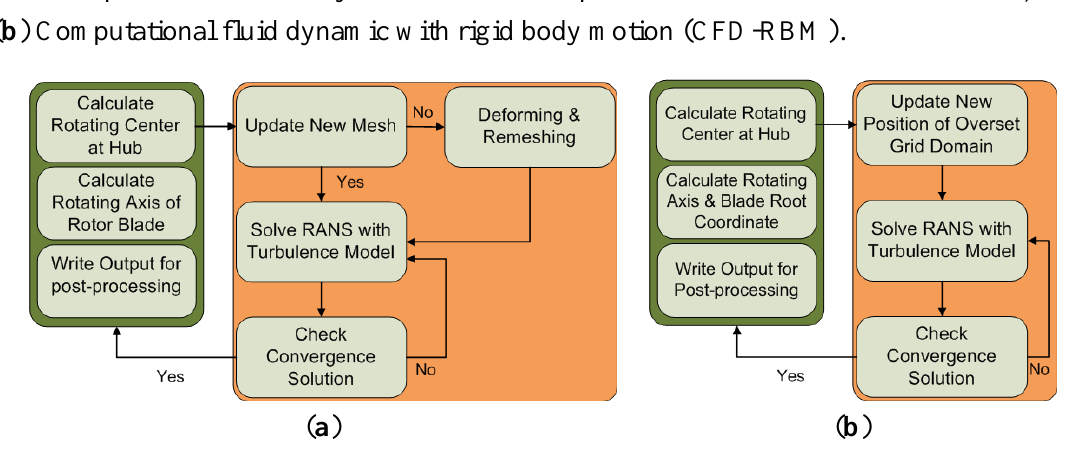
Figure 5. Computational flowchart for computational fluid dynamic (CFD) approaches.